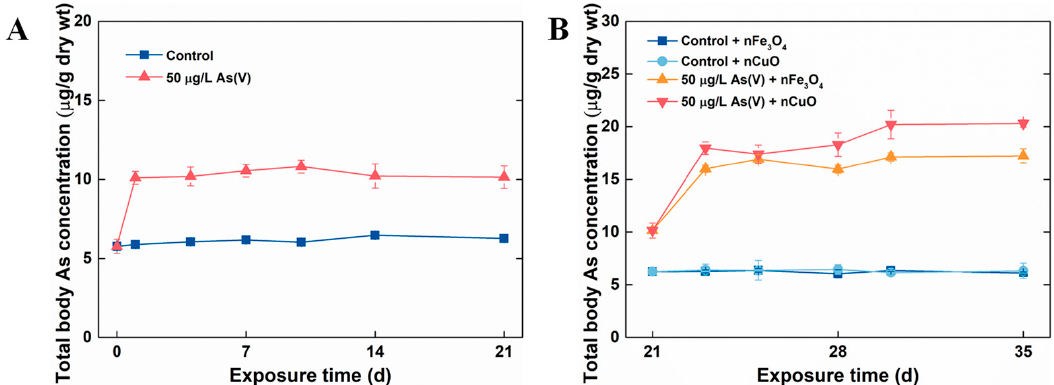
Figure 2. Dynamics of total body As concentrations in mussels without MNPs ( A ) and with MNPs ( B ). Data are mean ± SD (n = 4).